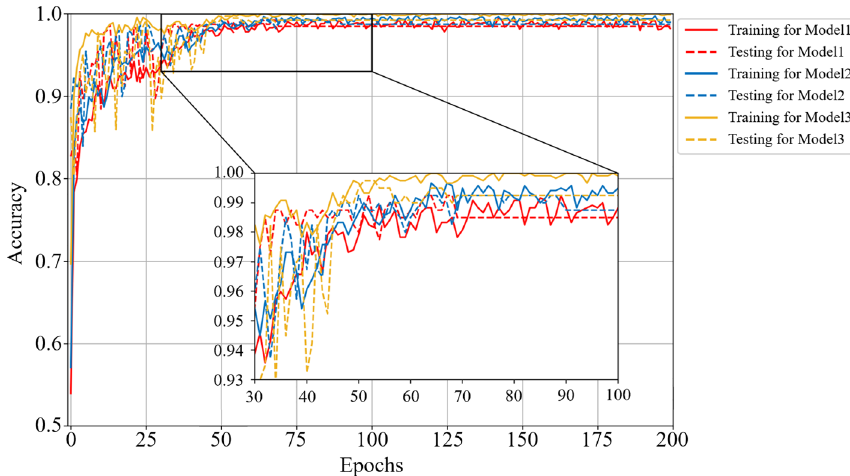
Figure 6. Comparison curves of accuracy performance of different models on noiseless dataset.